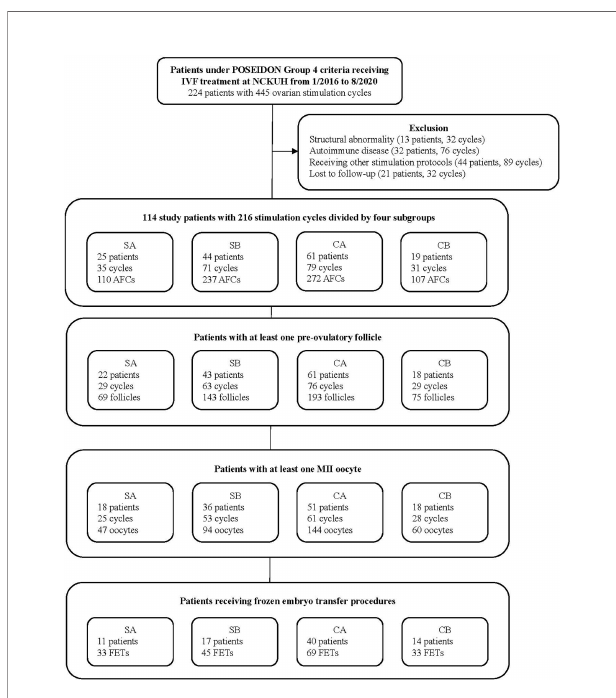
FIGURE 1 | Patient selection fl ow chart. POSEIDON, Patient-Oriented Strategies Encompassing IndividualizeD Oocyte Number; IVF, in vitro fertilization; NCKUH, National Cheng Kung University Hospital; SA, study group receiving administration of clomiphene citrate and letrozole in mild ovarian stimulation with gonadotropin-releasing hormone (GnRH) antagonist protocol; SB, study group receiving administration of clomiphene citrate and letrozole in mild ovarian stimulation with progestin-primed ovarian stimulation (PPOS) protocol; CA, control group receiving conventional ovarian stimulation with the GnRH antagonist protocol; CB, control group receiving conventional ovarian stimulation with the PPOS protocol; AFC, antral follicle count; MII, metaphase II; FET, frozen embryo